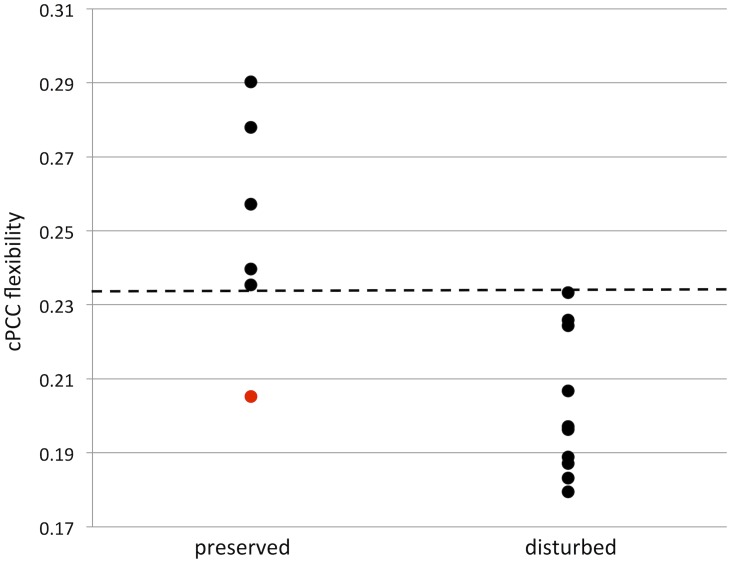
Memory and cPCC flexibility.Scatterplot of contralateral posterior cingulate cortex (cPCC) flexibility and memory. Patients with memory disturbance had decreased cPCC flexibility compared to memory preserved patients (p < 0.01). Dotted line indicates a threshold of 0.234, which separates memory preserved and disturbed patients, apart from patient 8 in Table 1 (indicated in red in this figure).